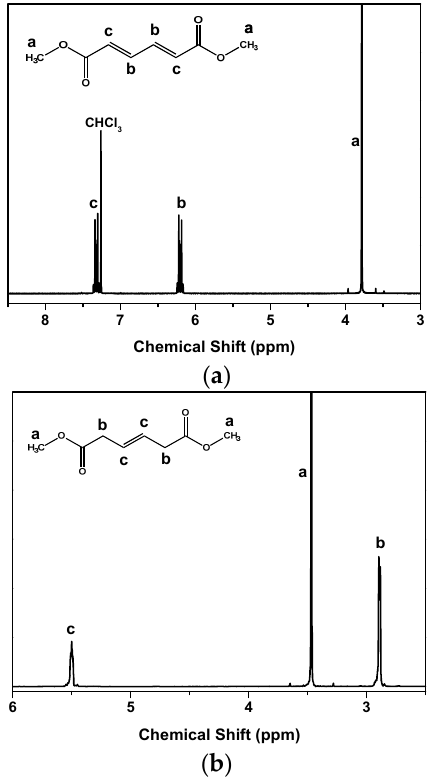
Figure 1. 1 H-NMR spectrum of ( a ) trans,trans -dimethyl muconate ( tt MUC) and ( b ) trans, β -dimethyl hydromuconate (TBHM).